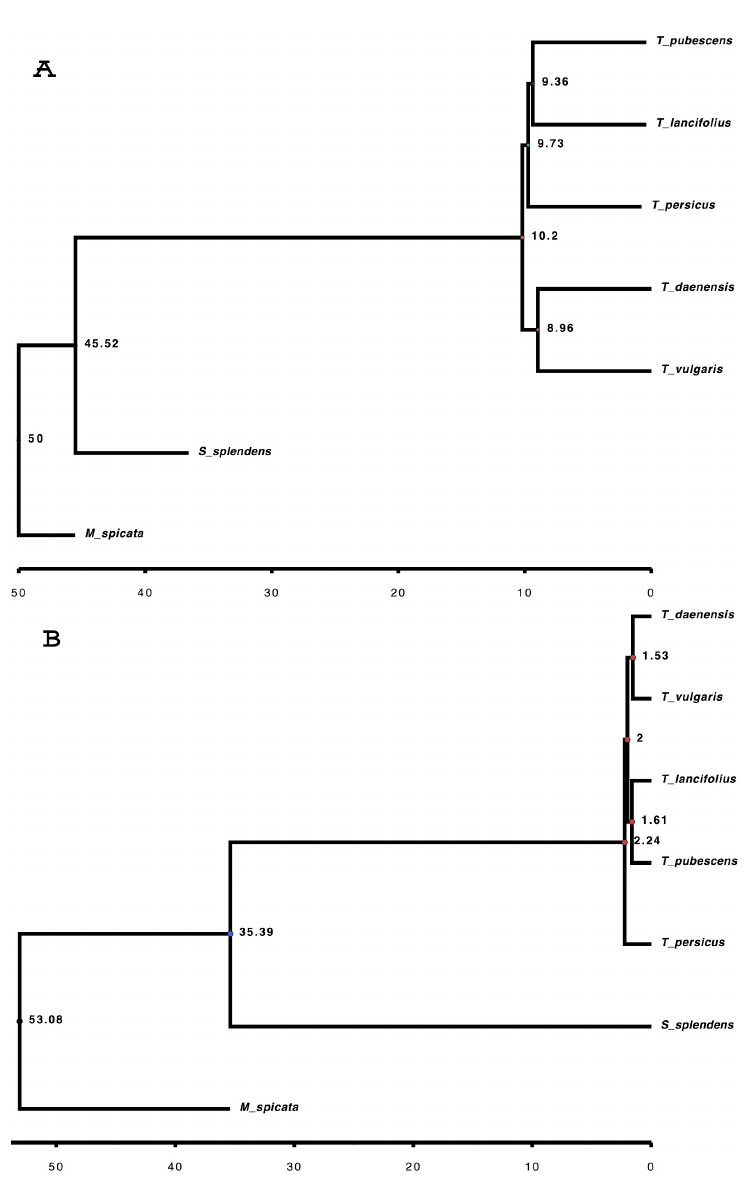
Figure 6. Phylogenetic relationships among five Thymus species inferred from 592 single-copy orthogroups. ( A ) Maximum likelihood tree. ( B ) Bayesian tree.